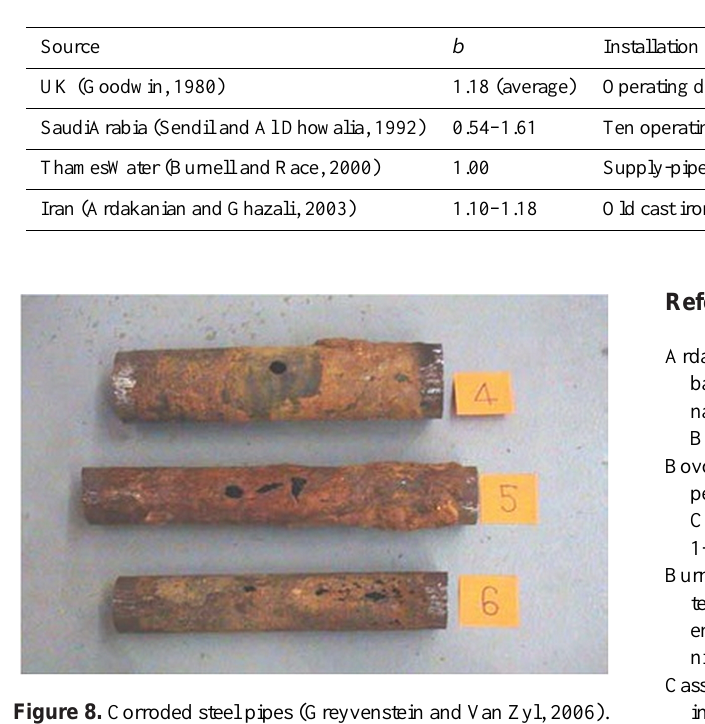
Table 1. Exponent b values as reported in literature.